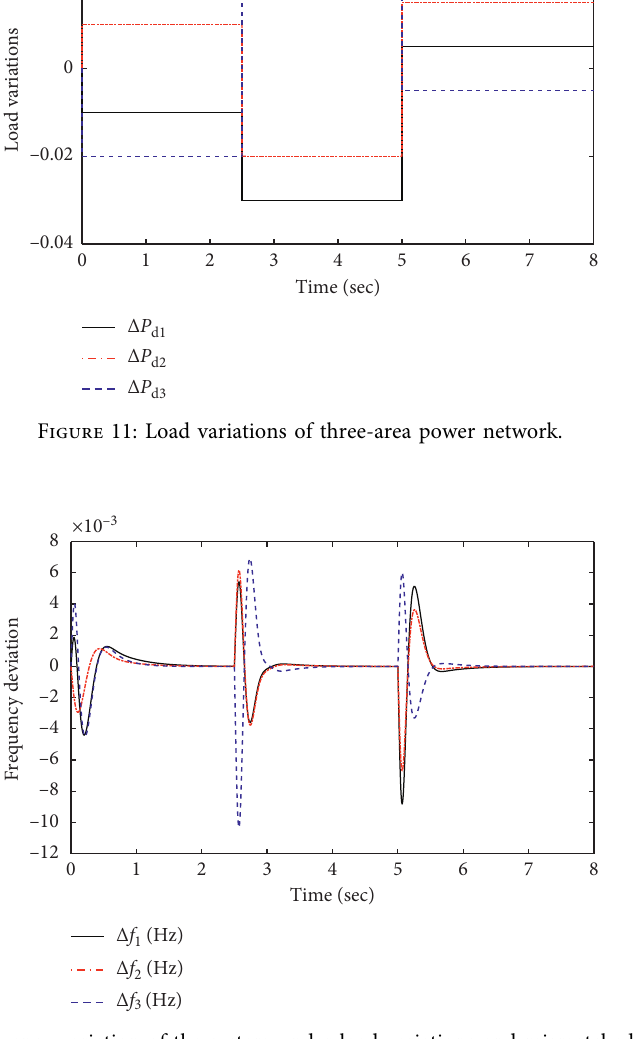
Figure 12: Frequency variation of the system under load variations and mismatched uncertainty.